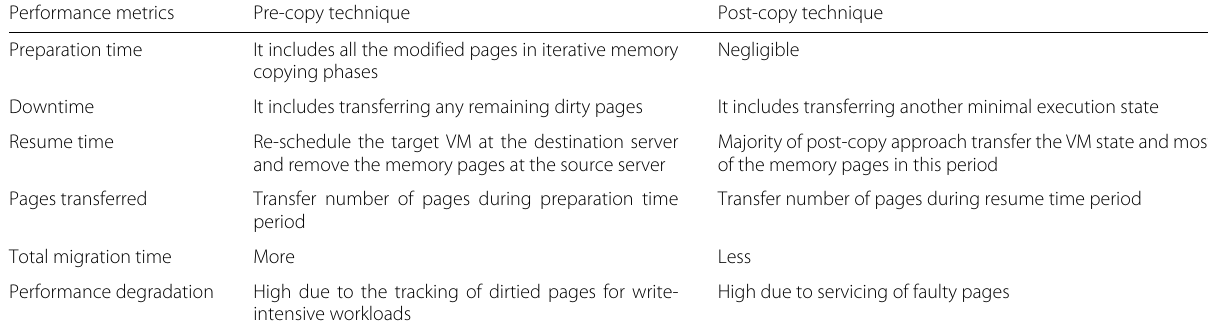
Table 1 Comparison table of pre-copy and post-copy based on Performance metrics Performance